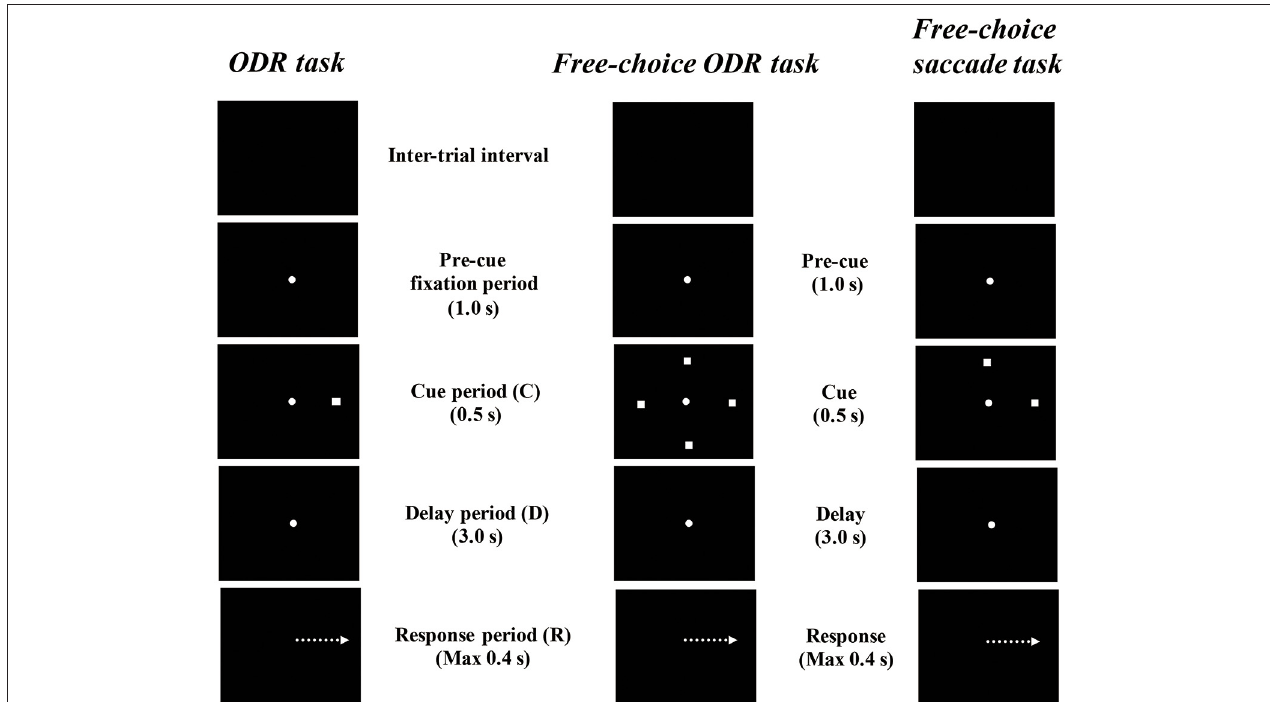
FIGURE 2 | Diagrams of the temporal sequence of the behavioral tasks. An ordinary oculomotor delayed-response (ODR) task, a free-choice ODR task used by Watanabe et al. (2006) and Watanabe and Funahashi, and a free-choice memory-guided saccade task used by Mochizuki and Funahashi (2016).